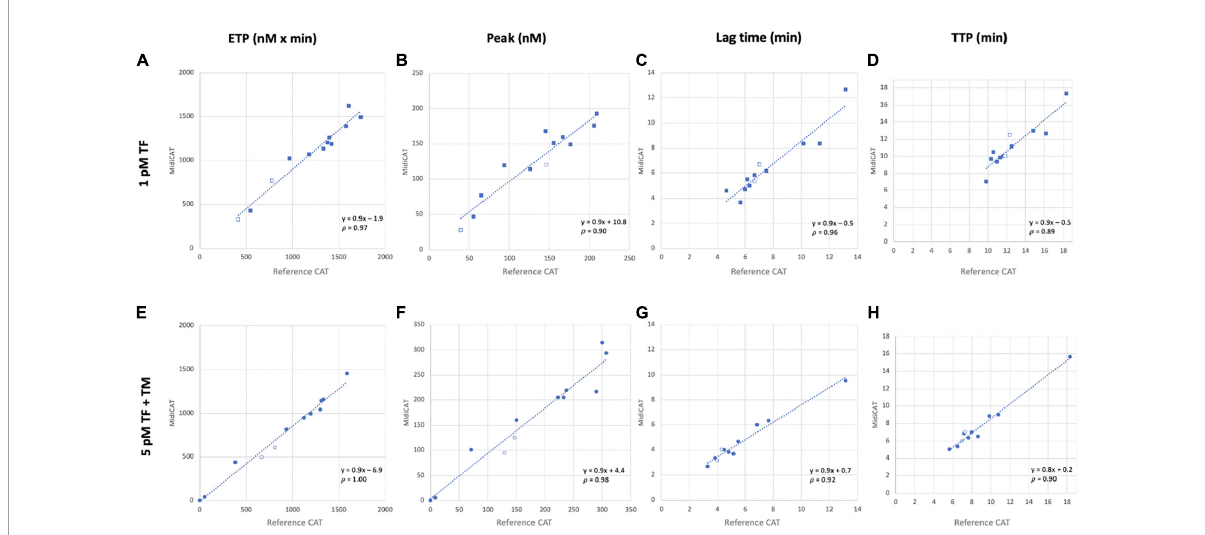
FIGURE1 Correlation of thrombin generation parameters obtained with MidiCAT variant method with those of the reference method. Coagulation was initiated with 1 pM (A–D) and 5 pM TF in the presence of TM (E–H) . Plots for endogenous thrombin potential [ETP, nM × min; (A, E) ], peak [nM; (B, F) ], lagtime [min; (C, G) ], and time to peak [TTP, min; (D, H) ]. Filled dots: patients’ plasma samples; empty dots: commercial normal pooled plasma. Plasma’s volume used: 40 µ L for MidiCAT method and 80 µ L for CAT method. CAT, calibrated automated thrombography; TF,